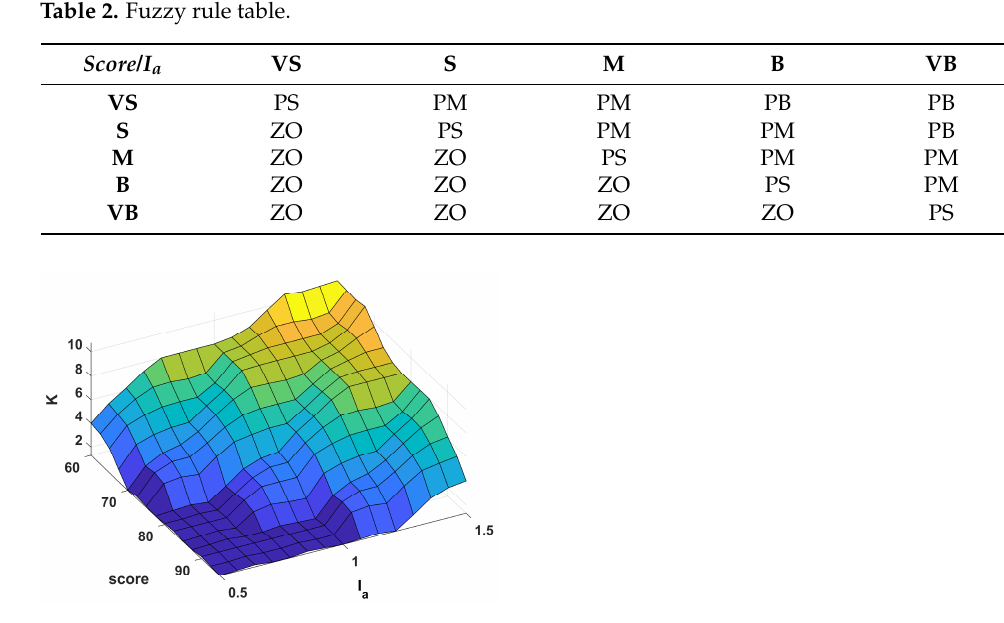
Figure 6. Membership functions for the input and output.